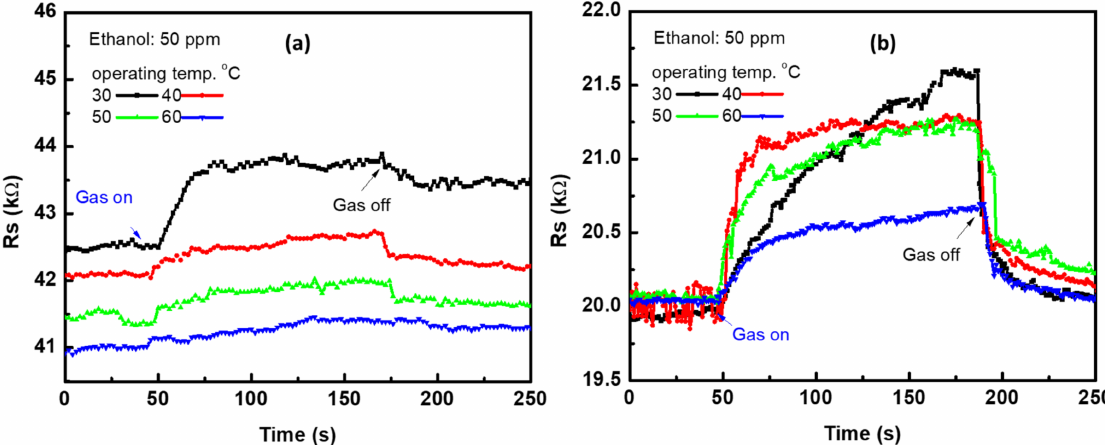
Figure 4. Single sensor signal at various operating temperatures ranging from 30–60 ◦ C for CNTs